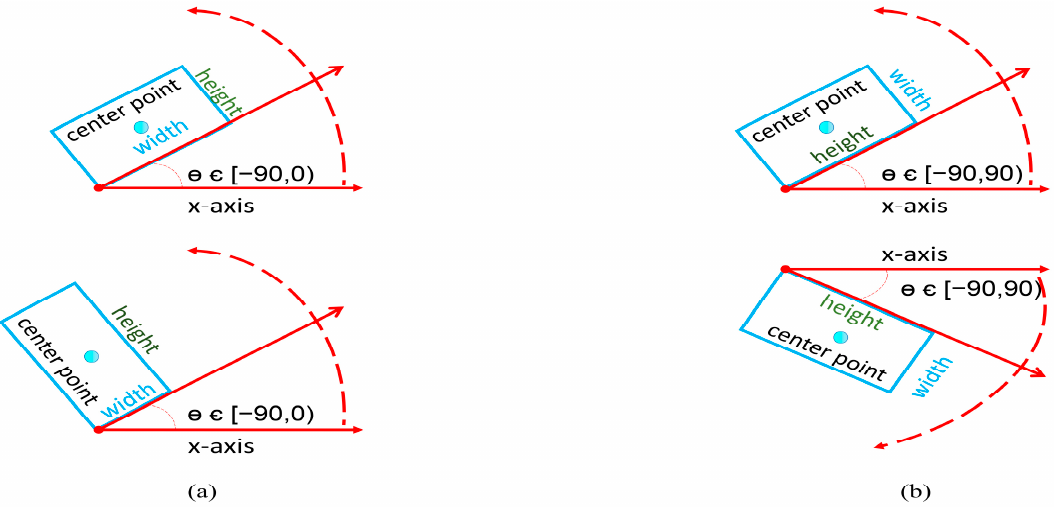
Figure 10. Method of defining the rotating frame for different angle ranges. ( a ) Five-parameter method with an angular range of 90°. ( b ) Five-parameter method with an angular range of 180°.